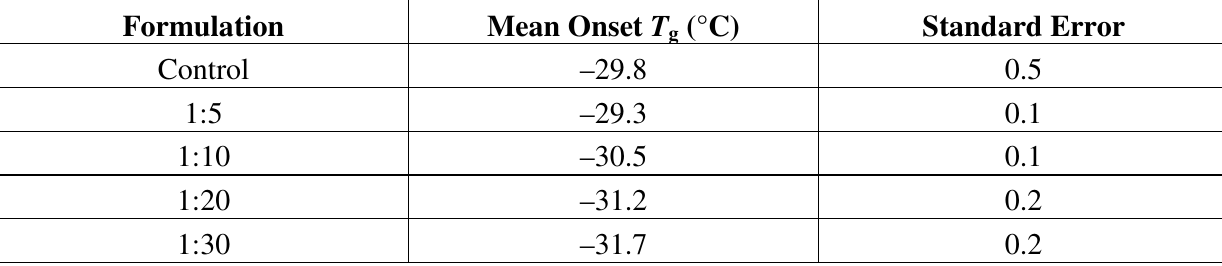
Table 2. Glass transition data of the formulations consisting of various ratios of gelatin:sodium chloride.